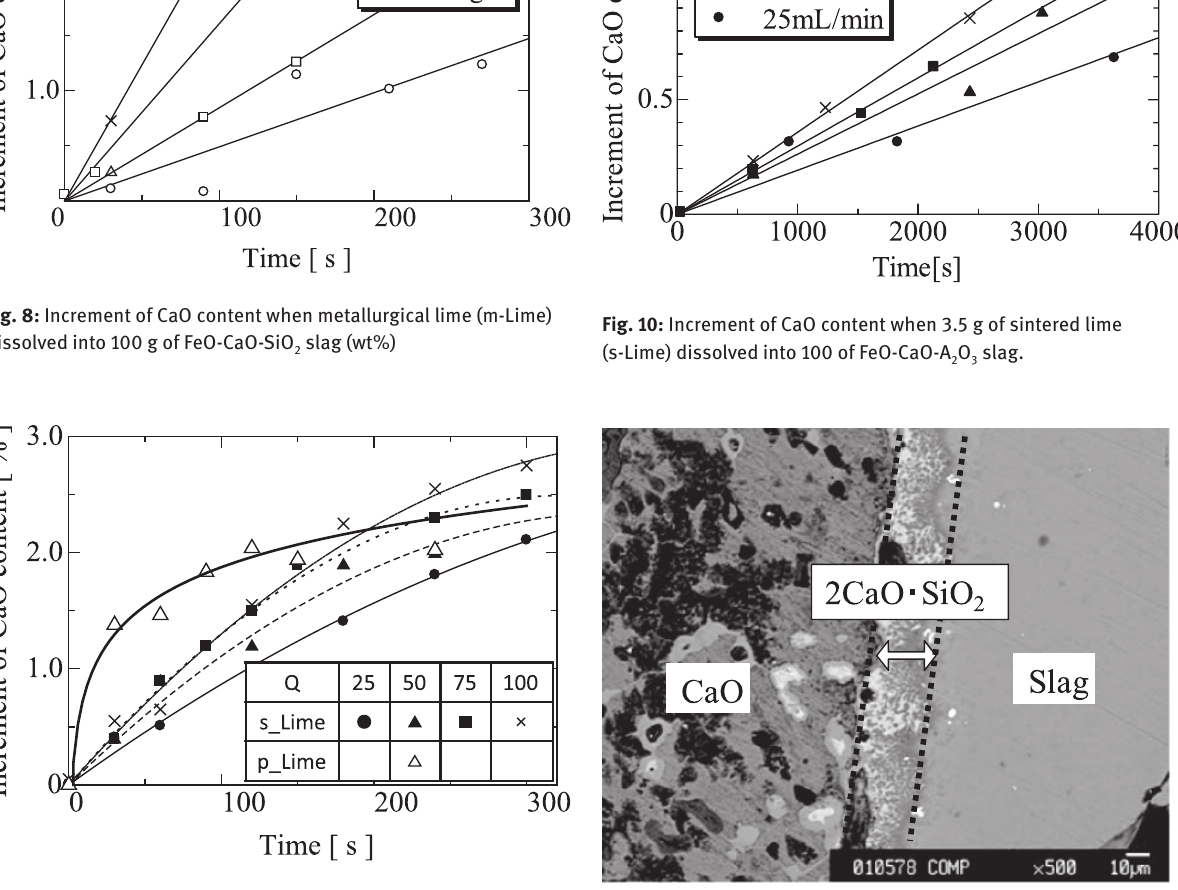
Fig. 11: Cross sectional image of interface between lime and slag when sintered lime (s-Lime) dipped into FeO-CaO-SiO